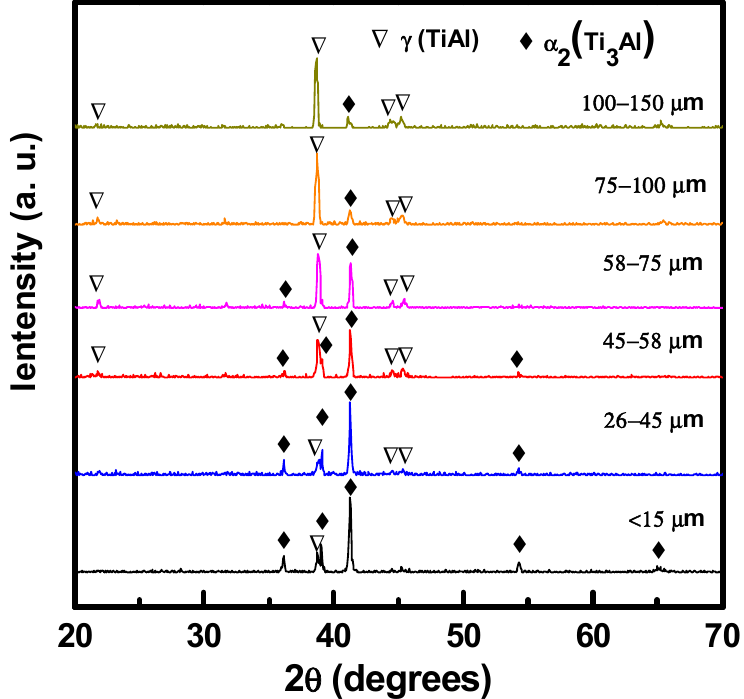
Figure 1. XRD patterns of the as-atomized high-Nb TiAl powders with different sizes.